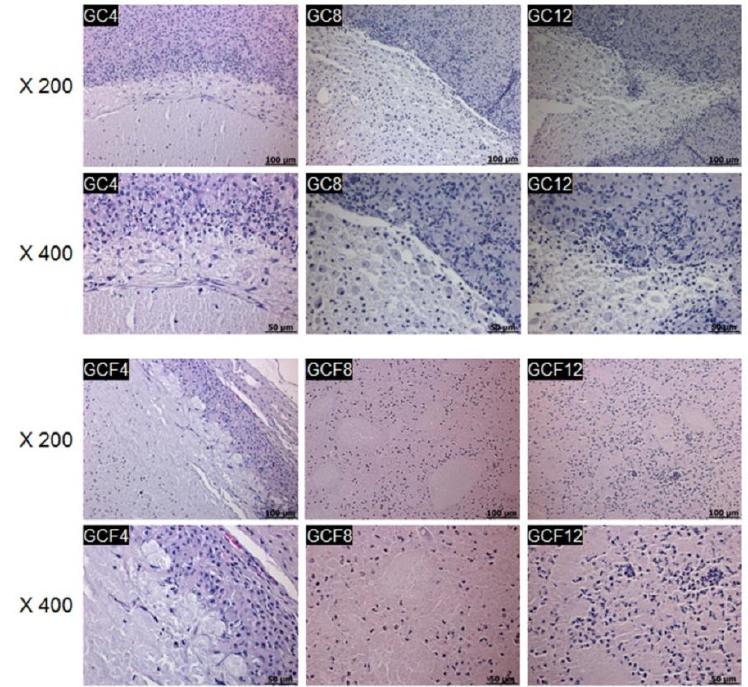
Figure 6. Hematoxylin and eosin (H&E) stained sections of the MCL without (GC) or with (GCF) the osteogenic factors after 4, 8, and 12 weeks. The numbers indicate the implantation time and the scale bars indicate 100 µm for the ×400 magnification and 50 µm for the ×200 magnification.